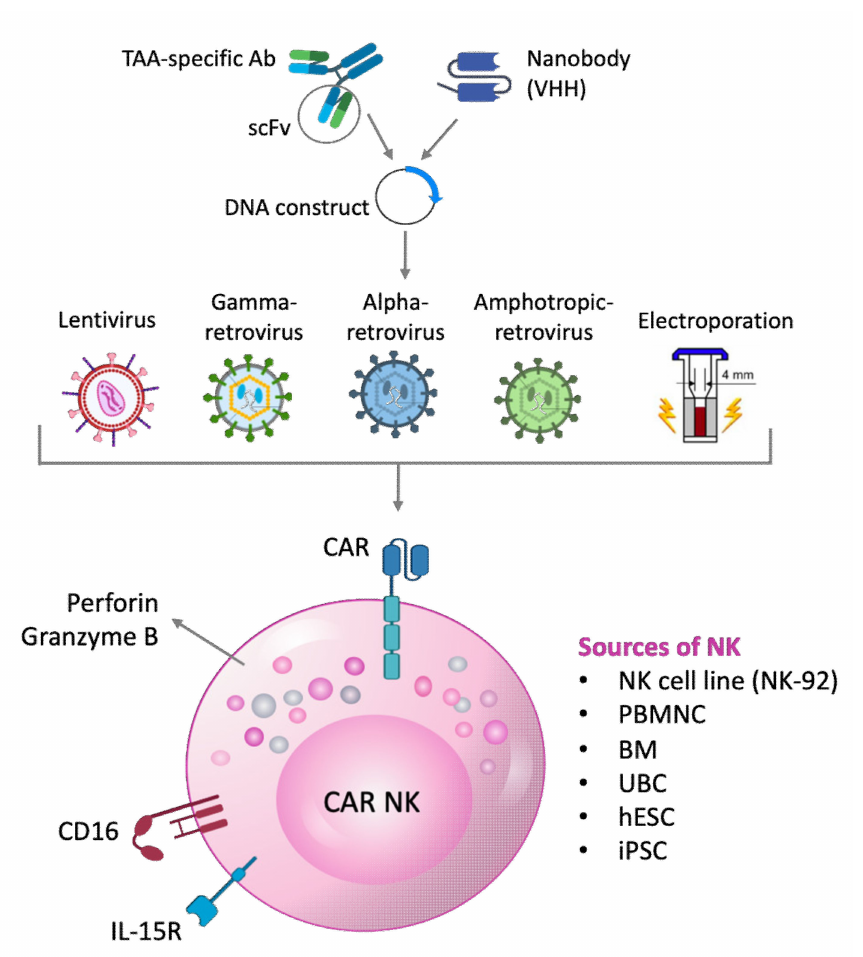
Figure 2. Methods of generating CAR-NK cells. NK cells can be obtained from various sources of an autologous or allogenic donor. The CAR construct, consisting of the scFv sequence (derived from either a tumor antigen / TAA-specific Ab or nanobodies) linked to activatory domains, is made via molecular cloning or gene synthesis techniques. This construct is expressed in NK cells using viral or non-viral transduction (i.e., electroporation). When exposed to the tumor antigen-expressing tumor cells, CAR-NK cells become activated and release cytokines and cytolytic agents such as perforin and granzyme B. Along with CAR, other molecules may be co-transduced to improve persistence, migration, and / or cytotoxicity of CAR-NK cells. Among them, the IL-15 cytokine receptor and the Fc γ RIII CD16 (in NK-92MI lacking CD16) which triggers ADCC. PBMNC: peripheral blood mononuclear cells; BM: bone marrow; UBC: umbilical cord; hESC: human embryonic stem cells; iPSC: induced pluripotent stem